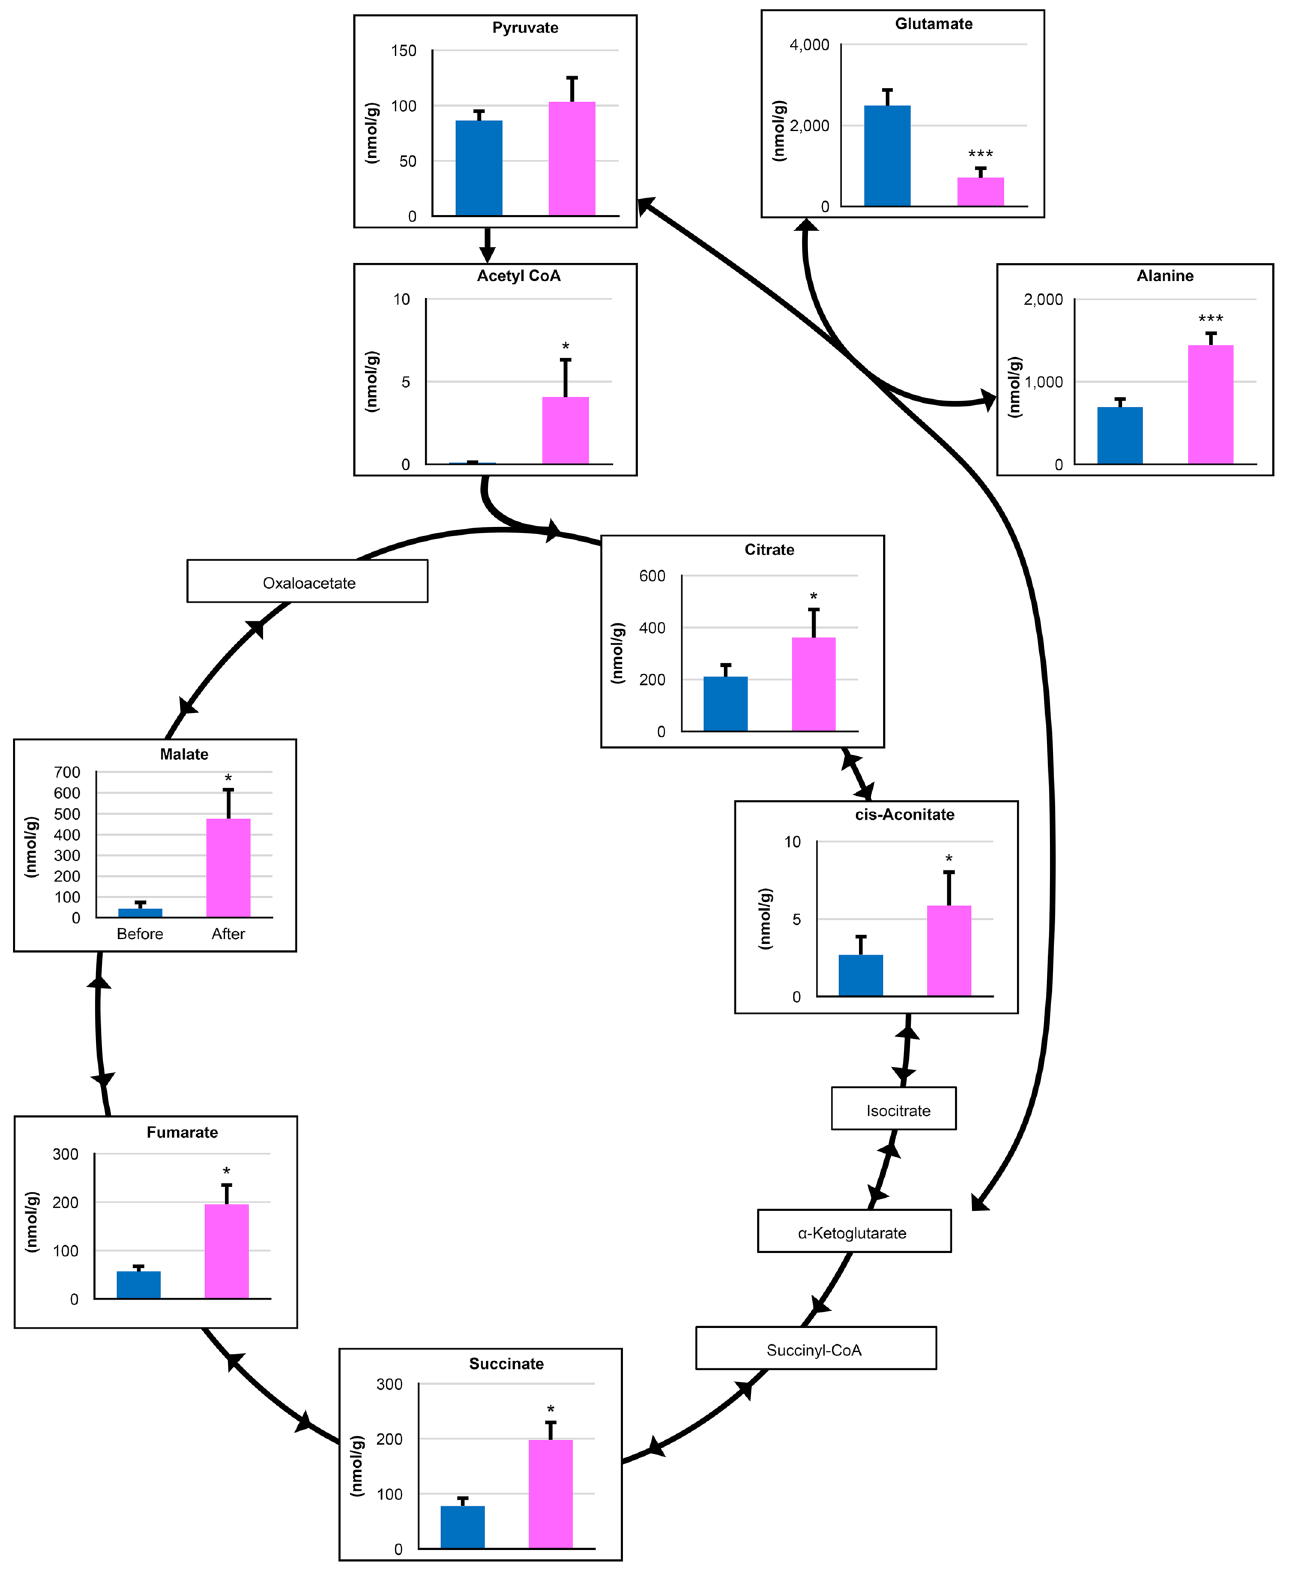
Figure 3. Observed changes in metabolites mapped onto the pathways associated with the TCA cycle. Asterisks show significant differences between before and after exercise by Welch’s t-test (* < 0.05, ** < 0.01, *** <